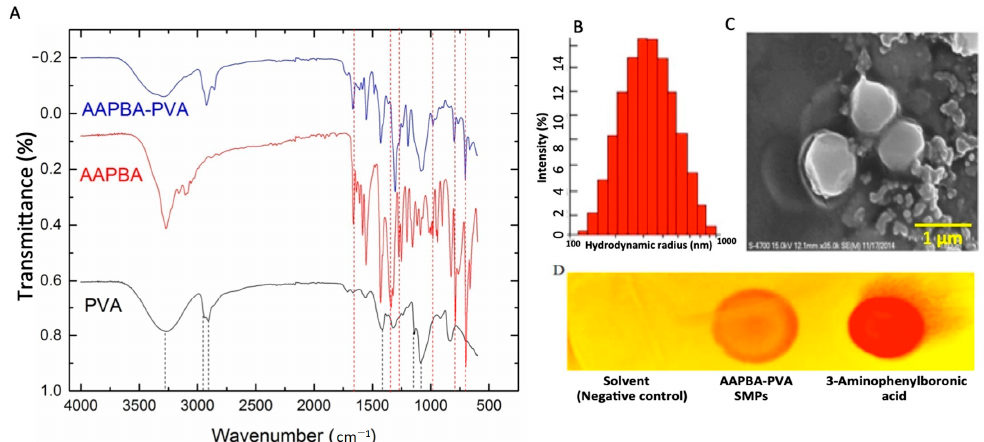
Figure 2. Characterization of the synthesized SMPs. ( A ) Confirmation of the synthesis of AAPBA-polyvinylalcohol (PVA) by Fourier-transform infrared spectroscopy (FTIR). The identified peaks of the chemical groups as follows: 1665 cm − 1 /C=O, 1636 cm − 1 /C=C, Amide II/1555 cm − 1 , Benzene/1429 cm − 1 , Boronate/1347 cm − 1 , OH/3200–3500 cm − 1 . ( B ) Size measurement of AAPBA-PVA SMPs by dynamic light scattering (DLS). ( C ) SEM image of AAPBA-PVA SMPs. ( D ) Functional integrity of boronate confirmed by the development of a red-colored spot in curcumin thin layer chromatography (TLC).